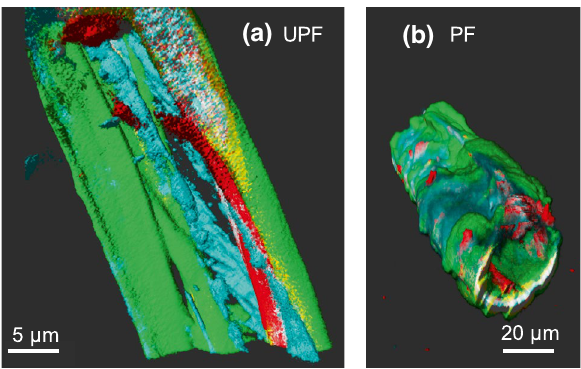
Fig. 6: 3D images of confocal fluorescence microscopy imaging. The fibres are labelled with CBM77 in green (binds to pectin), with CBM3a in cyan (binds to “semi-crystalline” cellulose) and with CBM- 1Cel6a in red (binds to crystalline cellulose). ( a ) UPF fibre and ( b ) PF